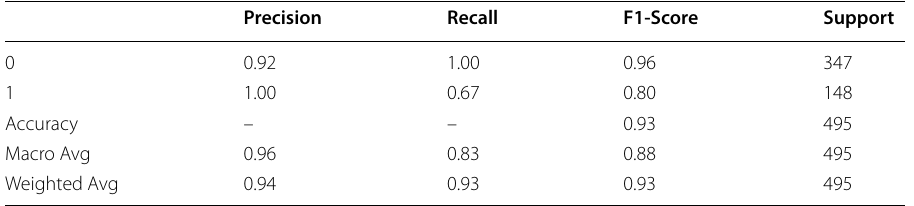
Table 5 Experiment 1 with ASTD dataset